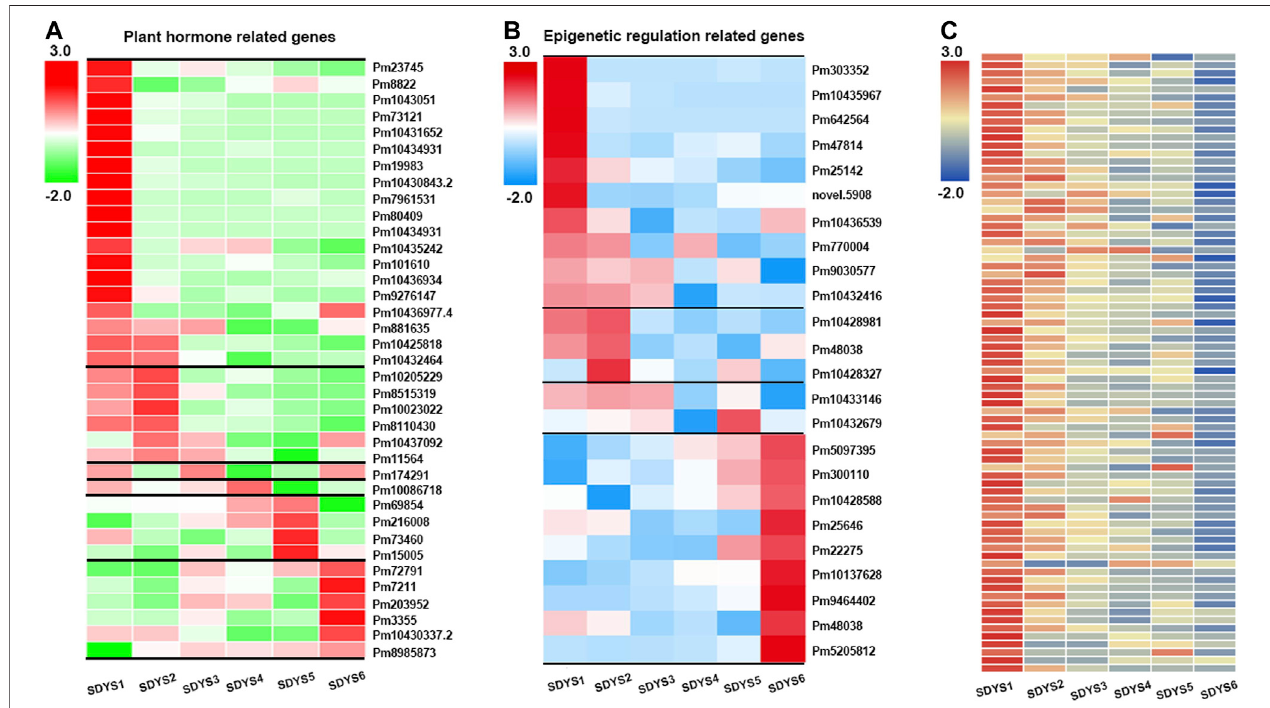
FIGURE 6 | Heat map of speci fi c expression of differentially expressed genes identi fi ed during each embryogenesis phase. (A) Plant hormone-related gene, (B) epigenetic regulation-related gene, and (C) NB-ARC-related gene expression in six different developmental stages.